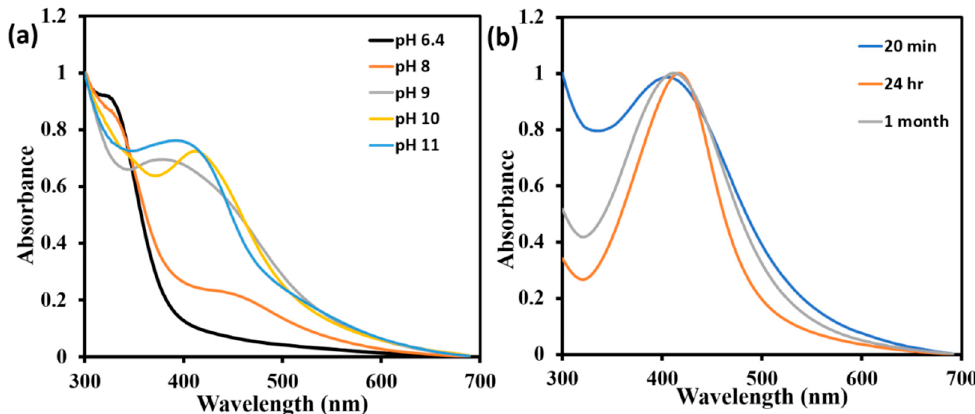
Figure 1. ( a ) UV–vis spectra of Artemisia vulgaris -mediated AgNPs at different pH and ( b ) UV–vis absorbed spectrum of Artemisia vulgaris -mediated AgNPs at different times.